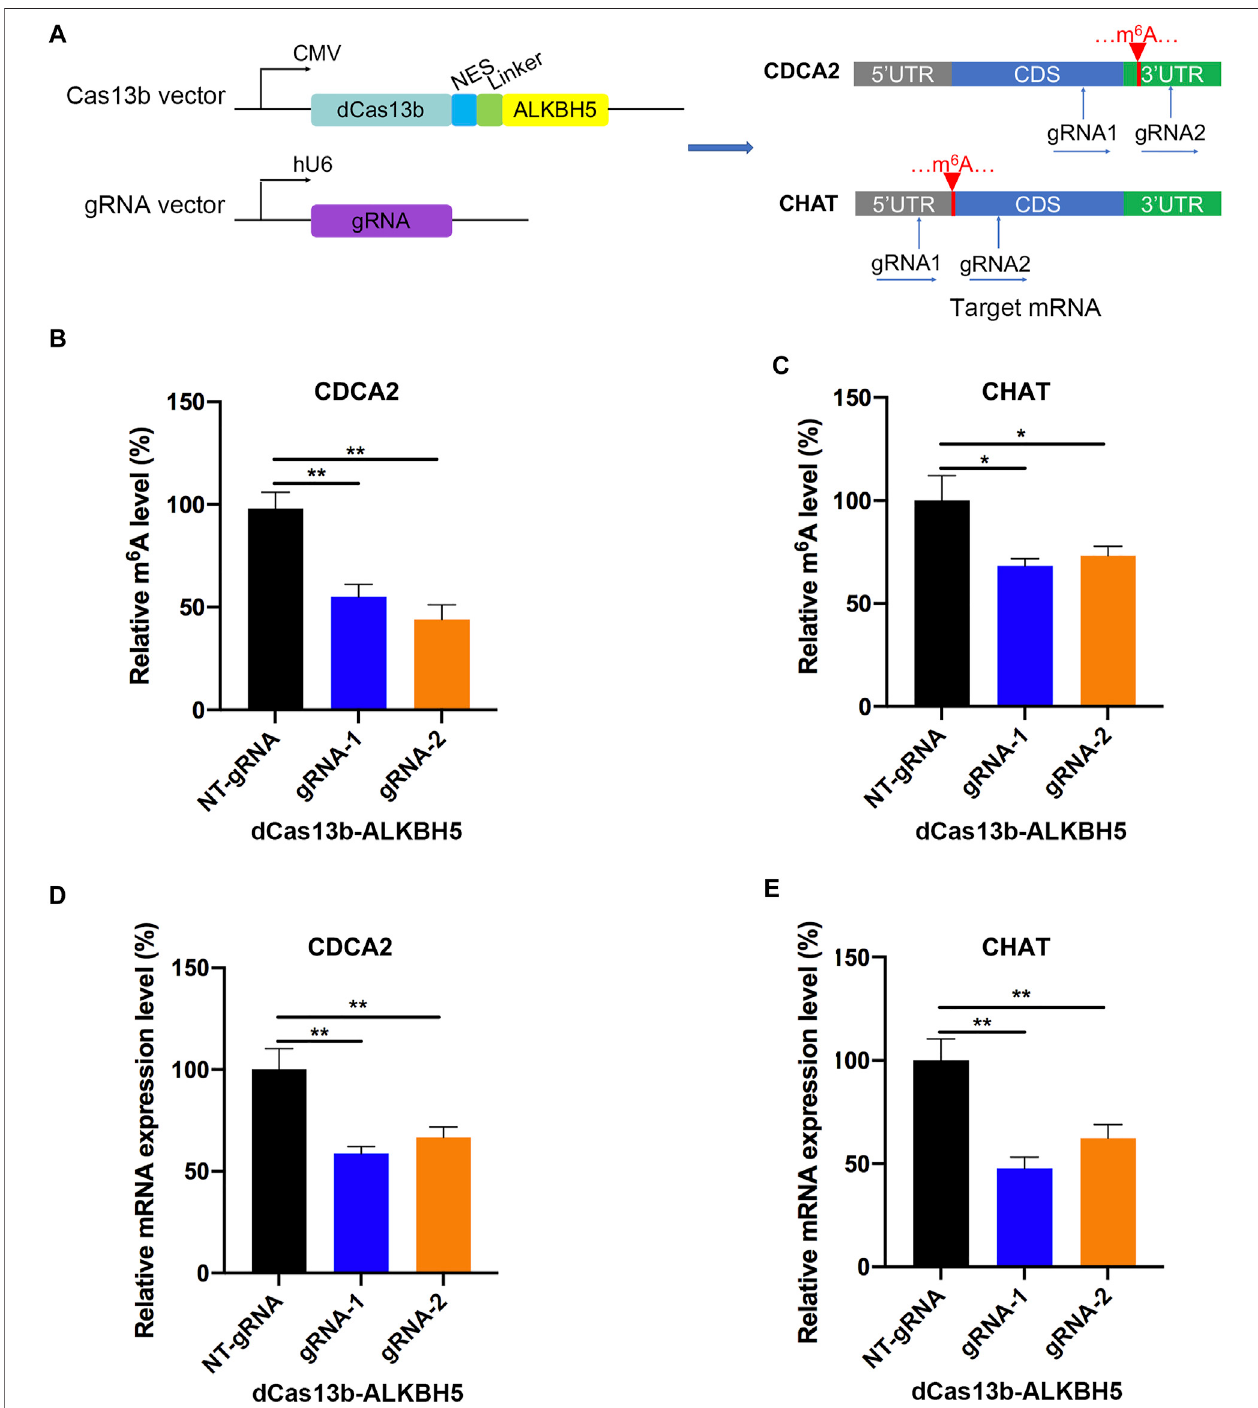
FIGURE 6 | dCas13b-ALKBH5 induces demethylation of m 6 A hypermethylated mRNA in RCC cells. (A) The design of dCas13b-ALKBH5 fusion protein and sgRNAs targeted with CDCA2 and CHAT mRNA m 6 A sites. (B,C) The m 6 A level of CDCA2 (B) and CHAT (C) mRNA in RCC cell line 786-O after transfected with dCas13b-ALKBH5 and gRNAs. (D , E) The mRNA levels of CDCA2 (D) and CHAT (E) in 786-O cell after transfection with dCas13b-ALKBH5 and gRNAs. ** p < 0.01.